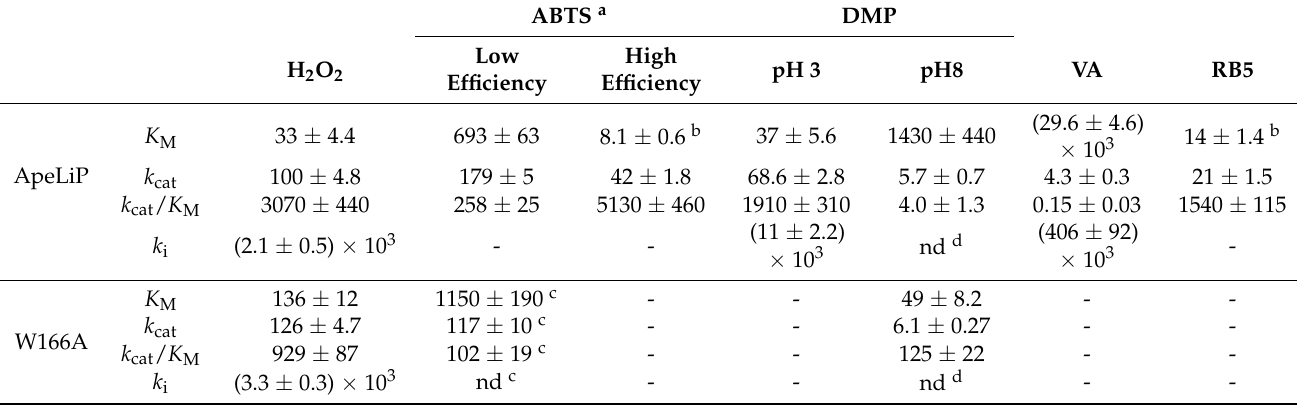
Table 2. Steady-state kinetic parameters— K M ( µ M), k cat (s − 1 ), k cat / K M (s − 1 · mM − 1 ), and k i ( µ M)—for H 2 O 2 , ABTS, DMP, VA, and RB5 reactions of ApeLiP and its W166A